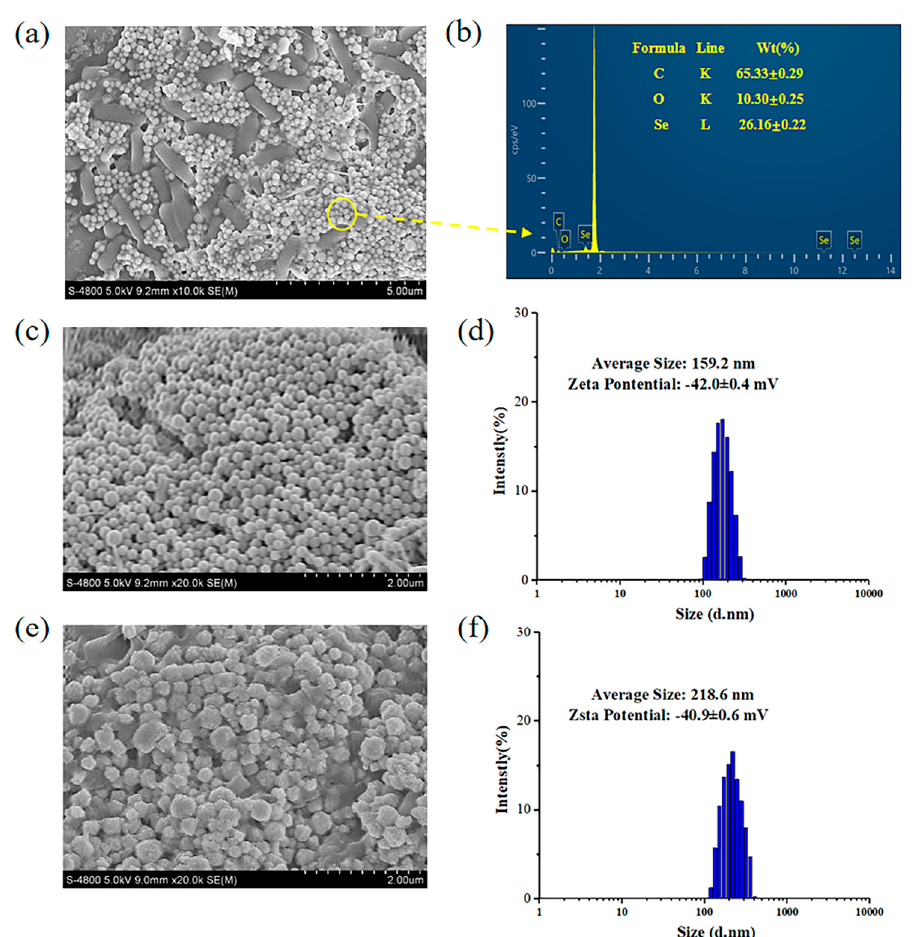
Figure 6. Morphology and composition characterization of SeNPs − E and SeNPs − S. ( a ) SEM micro- graphs of Bacillus sp. Q33 and SeNPs − S. ( b ) Energy dispersive X − ray diffraction. ( c ) SEM micro- graphs of SeNPs − S. ( d ) Particle size distribution of SeNPs − S. ( e ) SEM micrographs of SeNPs − E. ( f ) Particle size distribution of SeNPs − E.